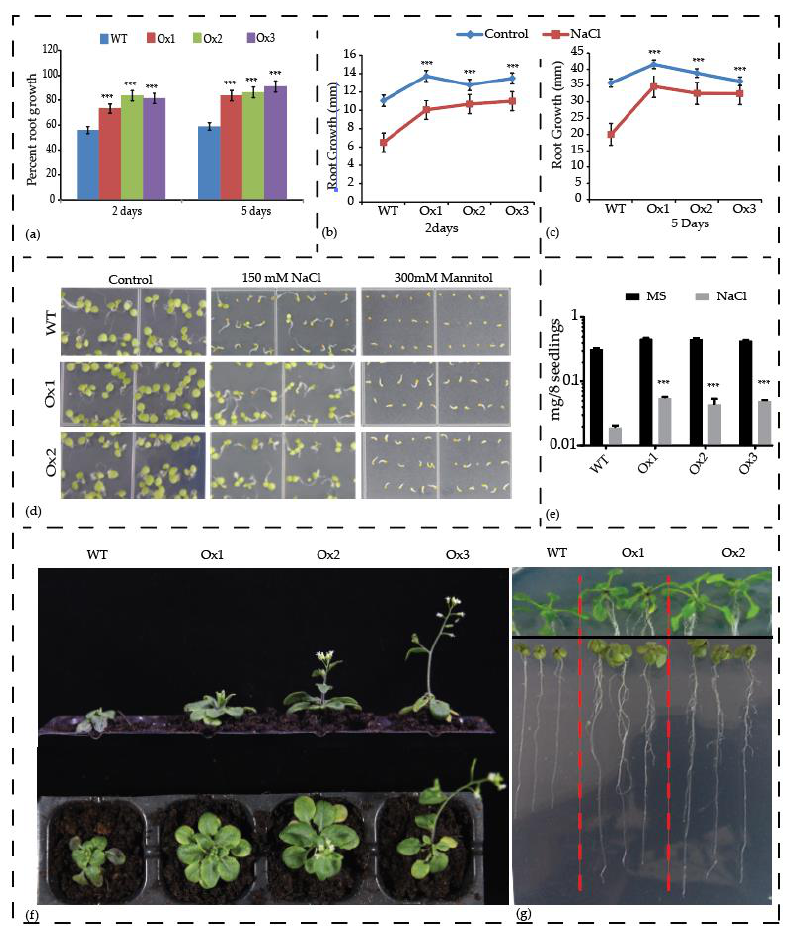
Figure 9. Overexpression of Ac CBL1 results in resistance to salinity and osmotic stress. ( a ) Percent root growth in 5-day-old wild-type and Ac CBL1 overexpressing seedlings transferred to new plates supplemented with 150 mm NaCl and analyzed after 2 days and 5 days of transfer. ( b ) Primary root growth after 2 days and ( c ) primary root growth after 5 days and ( d ) phenotype of 7-day-old Ac CBL1 overexpressing seedlings germinated under salinity (150 mM NaCl) and osmotic stress (300 mM mannitol). ( e ) Fresh weight of 5-day-old wild-type and Ac CBL1 overexpressing lines grown for an additional 10 days on 150 mM NaCl after transfer to new plate and analysis. ( f ) 15-day-old seedlings were subjected to saline irrigation with 250 mM NaCl for an additional 10 days and then photographed. ( g ) Seedlings grown for 5 days and transferred to new plate with (lower panel), or without (upper panel), 150 mM NaCl for 10 additional days and photographed. Vertical bars represent ± S.E., and *** indicates significantly different values between treatments ( p < 0.001).